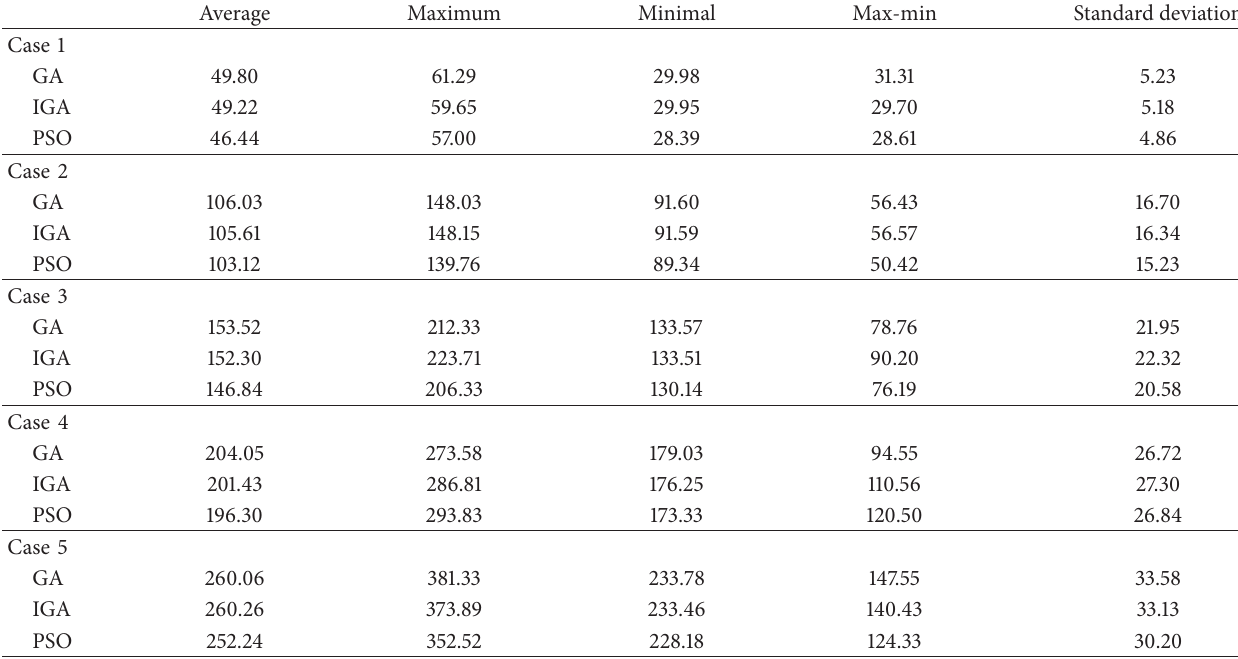
Table 6: The CPU time (sec) under different cases and by three different